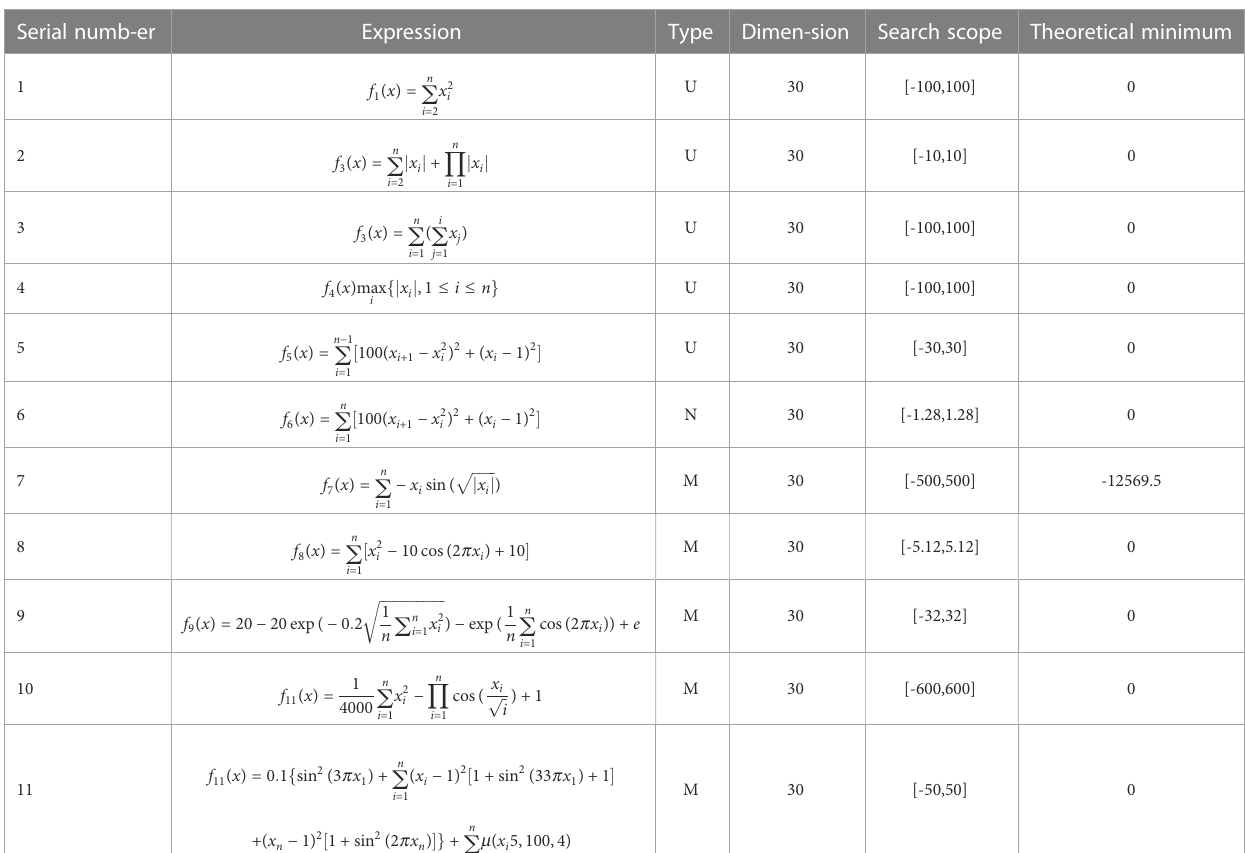
TABLE 1 Benchmark